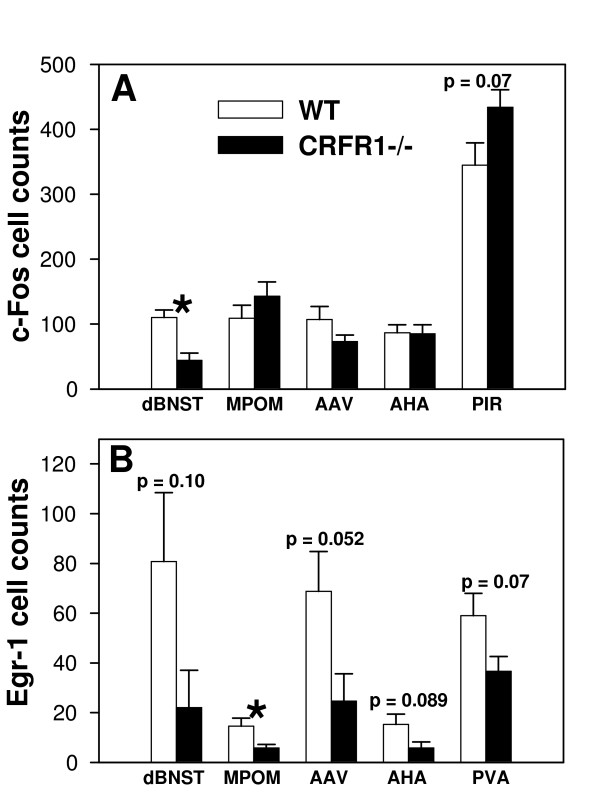
c-Fos and Egr-1 immunoreactivity in WT and CRFR1-/- mice. In terms of c-Fos immunoreactivity (A), significantly lowers levels of cell counts were found in BNSTd in CRFR1-/- relative to WT mice. In terms of Egr-1 immunoreactivity (B), significantly lower levels of cell counts were found in MPOM in CRFR1-/- relative to WT mice. Bars represent means ± SE. White bars indicate WT mice and black bars indicate CRFR1-/- mice. * = p < 0.05; one-way ANOVA. Other abbreviations: AAV = anterior amygdaloid area; AHA = anterior hypothalamic area; PVA = paraventricular nucleus of the thalamus.